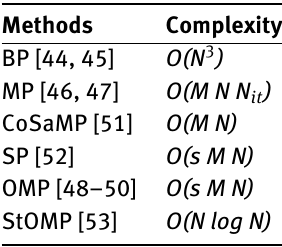
Table 2: Complexity of reconstruction